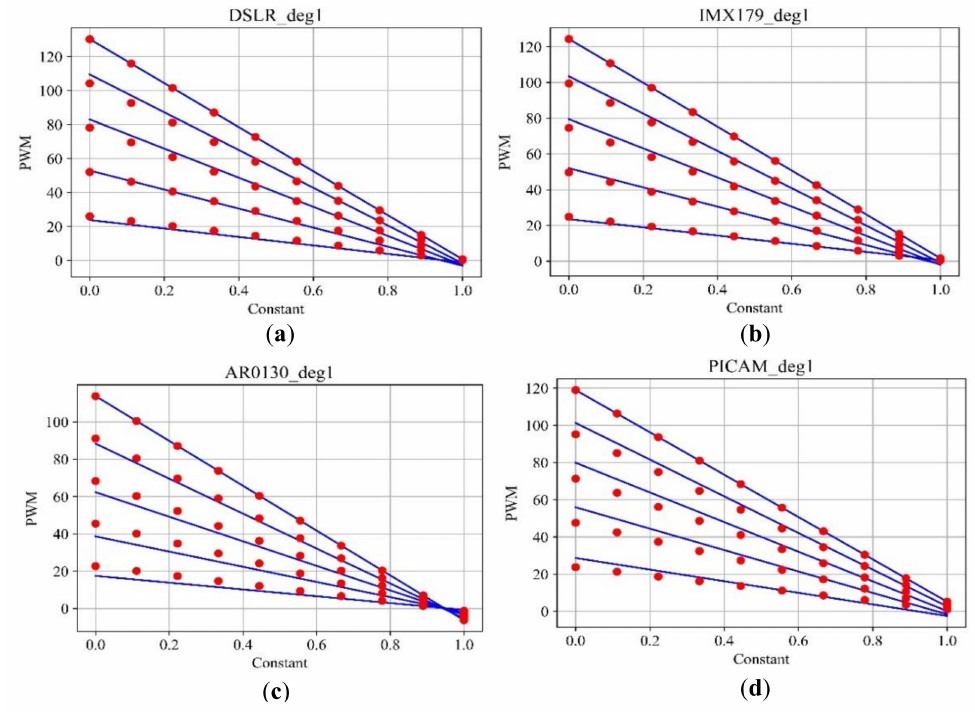
Figure 6. Relationship diagram for the first-order parameters for each camera: ( a ) DSLR; ( b ) IMX179; ( c ) AR0130; ( d )